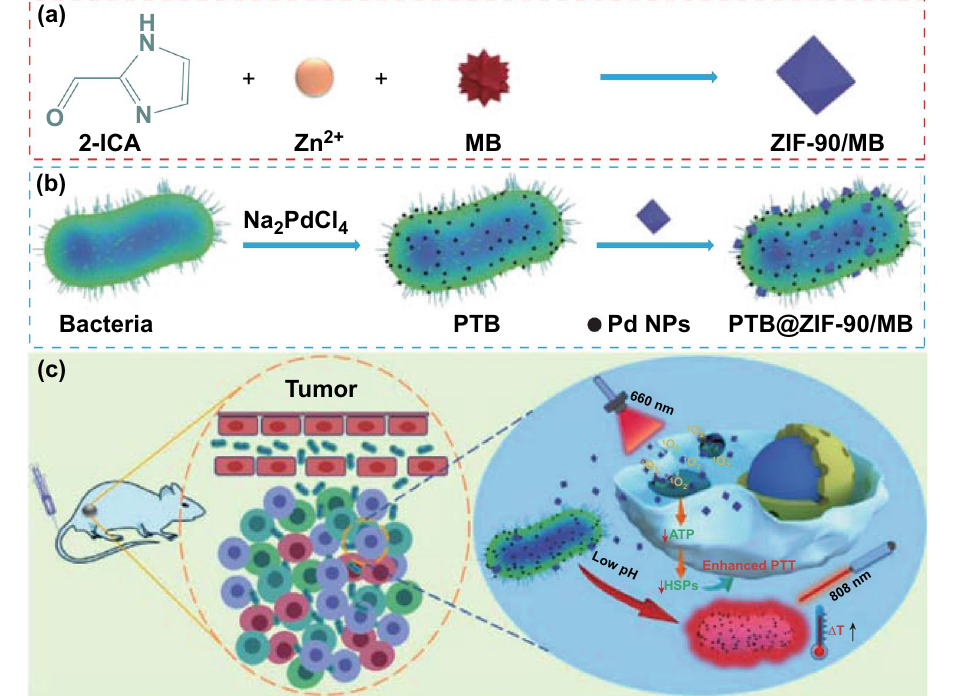
Fig. 3 Schematic of the PTB@ZIF-90/MB formation process and antitumor mechanism. a Synthetic procedure of photosensitizer methylene blue encapsulated zeolitic imidazole frameworks-90 (ZIF-90 MB). b Electrochemically active bacterium Shewanella oneidensis MR-1 reduces sodium tetra-chloropalladate (Na 2 PdCl 4 ) into palladium nanoparticles (Pd NPs) on bacterial cell surface to convert to photothermal bacterium (PTB),then ZIF-90/MB was conjugated on the surface of PTB to obtain PTB@ZIF-90/MB. c After PTB @ ZIF-90/MB reaches the acidic tumor site, ATP induces the release of MB, and further produces ROS under light to enhance the photothermal treatment effect of PTB. Reprinted with permission from Ref.